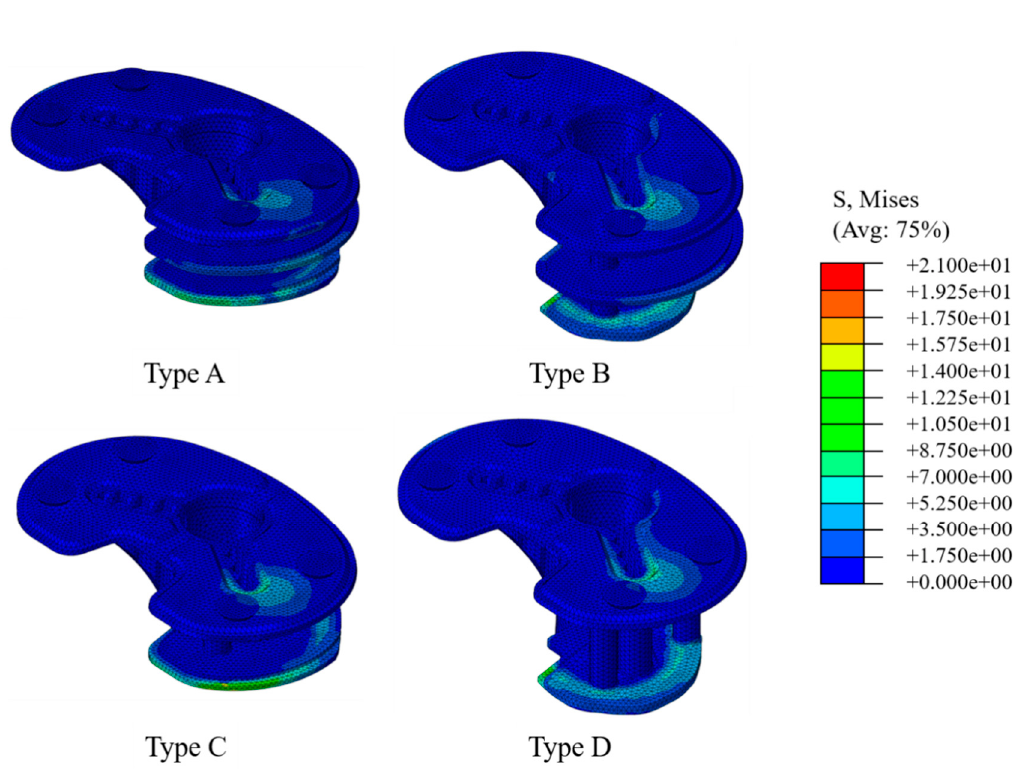
Figure 7. Representative stress distributions within the bone cements for the metal block augmentations of the medium and large uncontained bone defects. The red rectangle indicates the region identified by PVMS. Type A: Double metal block augmentation for medium uncontained bone defect, Type B: Double metal block augmentation for large uncontained bone defect, Type C: Single metal block augmentation for medium uncontained bone defect, Type D: Single metal block augmentation for large uncontained bone defect. (A, anterior; M, medial, L, lateral; P, posterior regions).